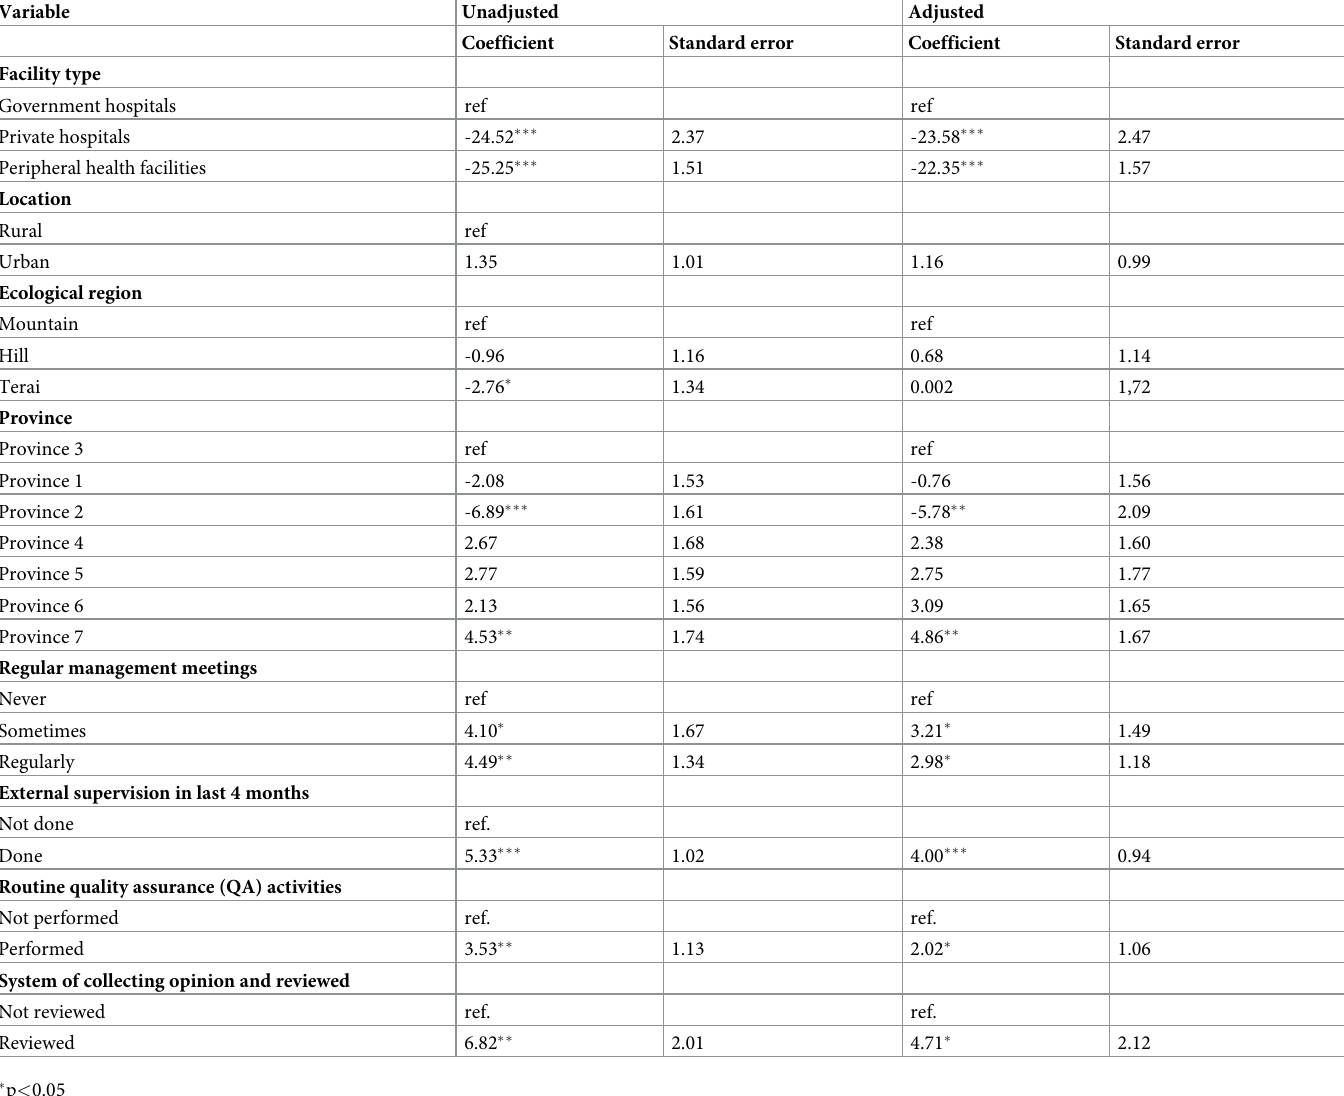
Table 3. Determinants of facility readiness integration for the FPMCH service in bivariate and multivariable linear regression (n =